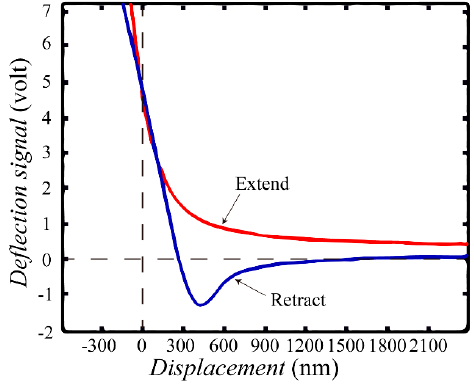
Figure 5. Curves close treatment.